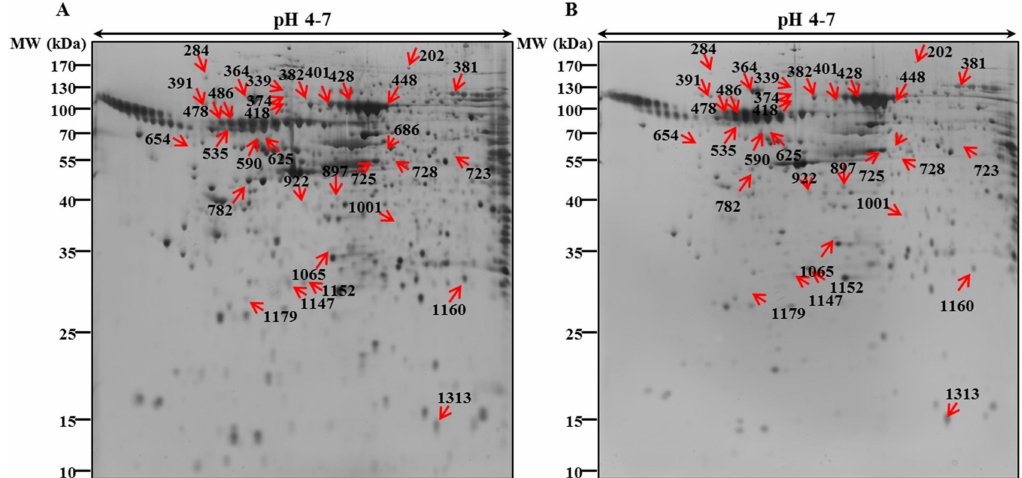
Figure 2. Representative Two-dimensional gel electrophoresis proteome maps of the control and pectolinarigenin-treated AGS cells. The ( A ) control and ( B ) PEC-treated (100 µ M) of AGS cells, the cells were incubated with 100 µ M of PEC for 24 h. The total proteins were separated on 18 cm linear IPG strips (pH 4–7) in the first dimension and in the second dimension with 12% second dimension sodium dodecyl sulfate-polyacrylamide gel electrophoresis (SDS-PAGE). The gels were silver stained. The numbered arrows indicate protein spots successfully identified by matrix-assisted laser desorption/ionization time-of-flight/time-of-flight tandem mass spectrometry. The experiments were performed in